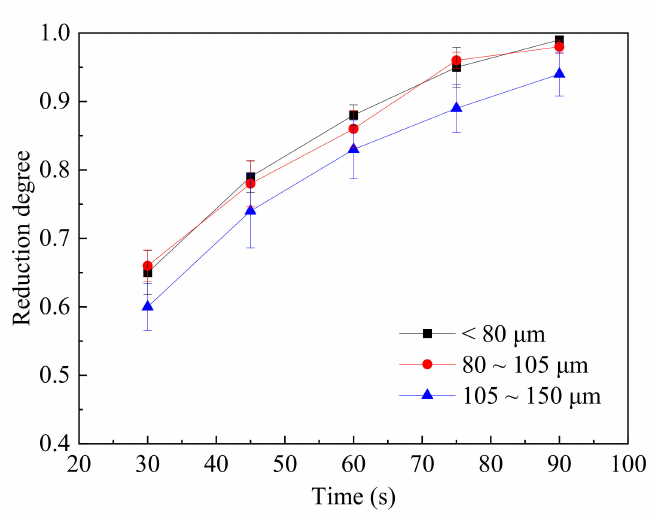
Figure 8. The relationship between the reduction degree and reduction time at different particle